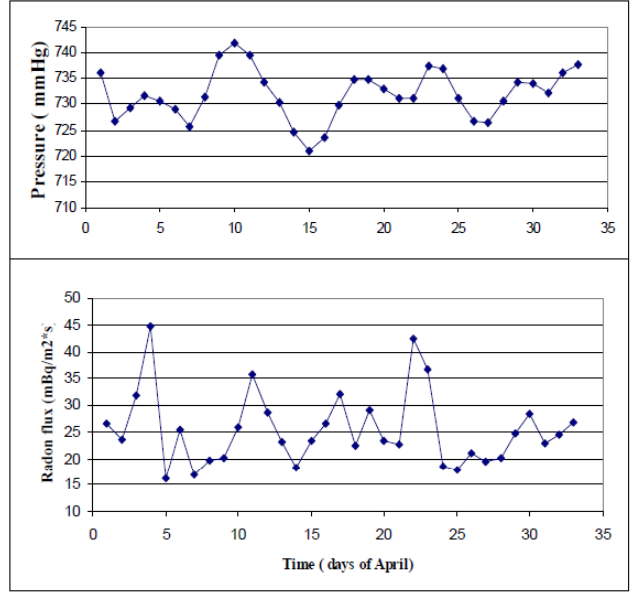
Figure 3. Daily variation of radon flux with pressure (taken from [137]) .